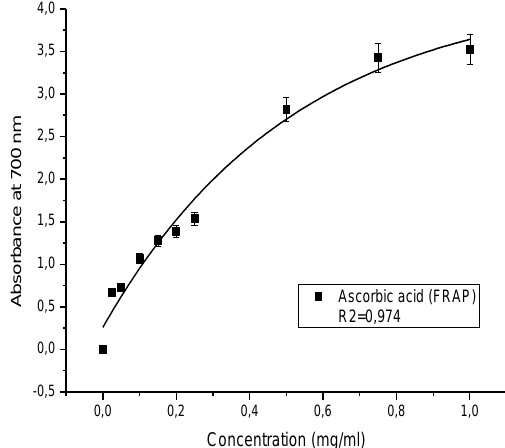
Figure 5. Antioxidant capacity of ascorbic acid as assessed by PFRAP assay.